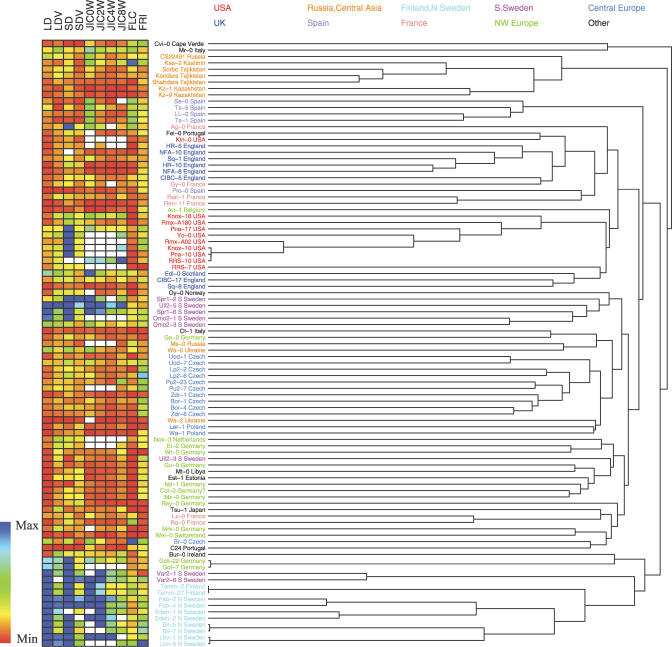
Summary of the Data Illustrating Strong Positive Correlations between Phenotypes and between Phenotypes and Genome-Wide RelatednessThe panel on the left gives the basic phenotypes used (see Table 1), with colors indicating relative values within each phenotype (white denotes missing data). The tree on the right shows a hierarchical clustering (UPGMA) of accessions based on their relative kinship (as measured by pairwise haplotype sharing). Colors for the accessions labels indicate geographic origins.